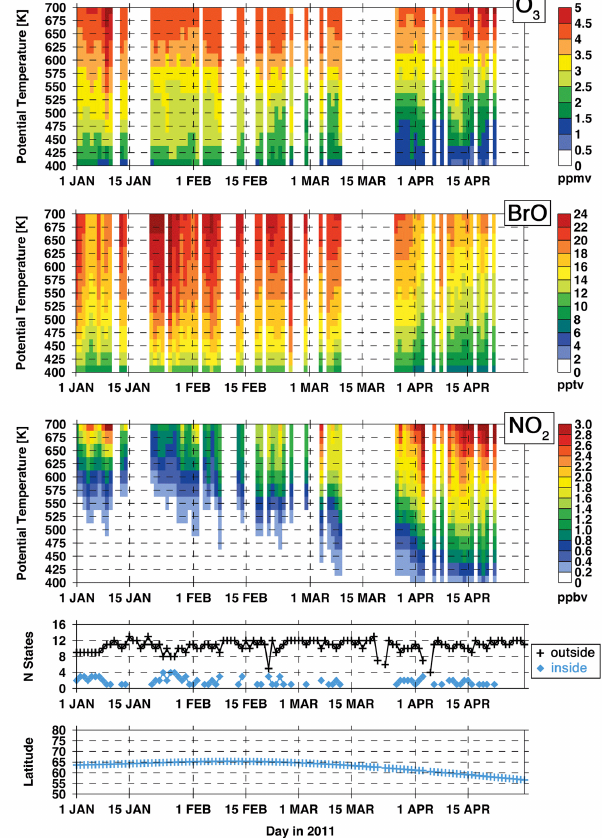
Fig. 6. Evolution of O 3 , BrO and NO 2 in the lower stratospheric Arctic polar vortex from 1 January 2011 to 30 April 2011 ob- tained from SCIAMACHY solar-occultation observations. Only measurements within the polar vortex (modified potential vorticity > 38PVU) are considered. The number of respective occultation measurements inside and outside the vortex, as well as the latitude of measurement, are shown in the bottom panels. Note the different plotting range of BrO and NO 2 compared to limb and model vortex averages (Figs. 5,